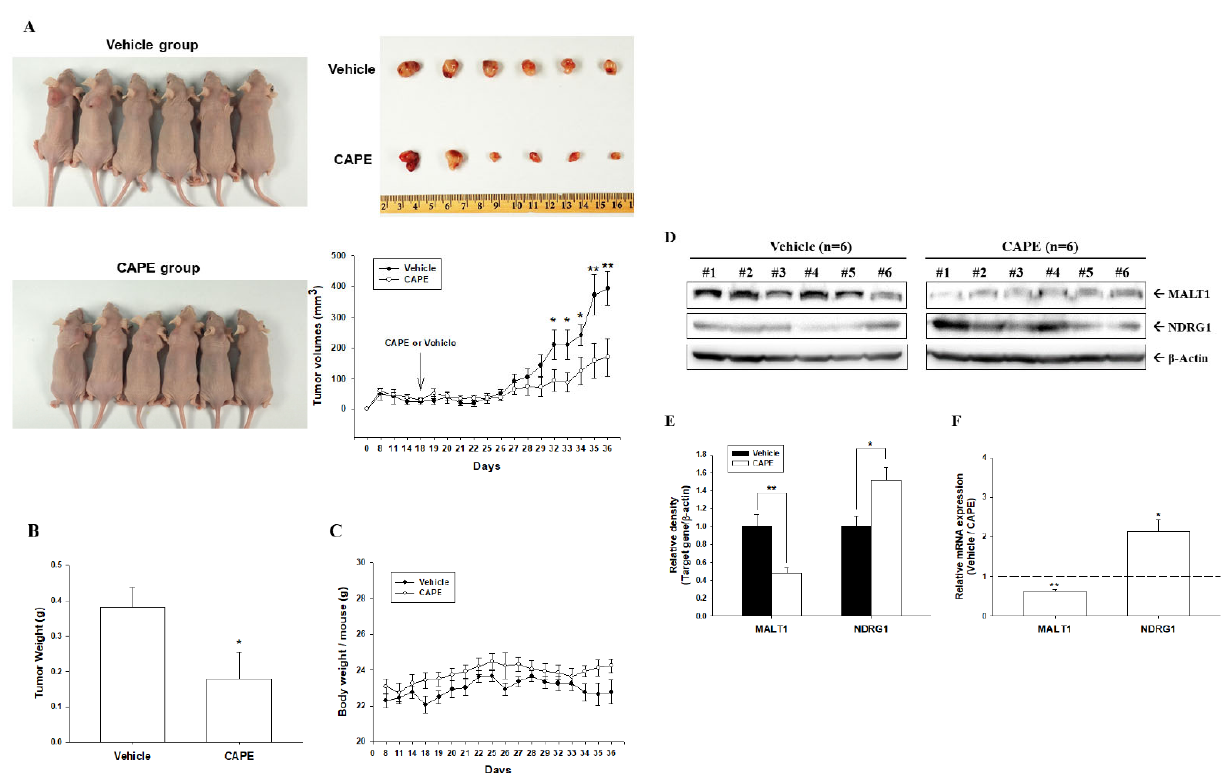
Figure 7. CAPE inhibits tumorigenesis of PC-3 cells in a xenograft mouse model. Athymic male nude mice were subcutaneously injected with PC-3 cells and randomly divided into two groups. When tumor volumes reached around 50 mm 3 (day 18) after subcutaneous xenografting of PC-3 cells, nude mice received vehicle (0.1% DMSO in PBS; n = 6) or CAPE (10 mg/kg; n = 6) injected